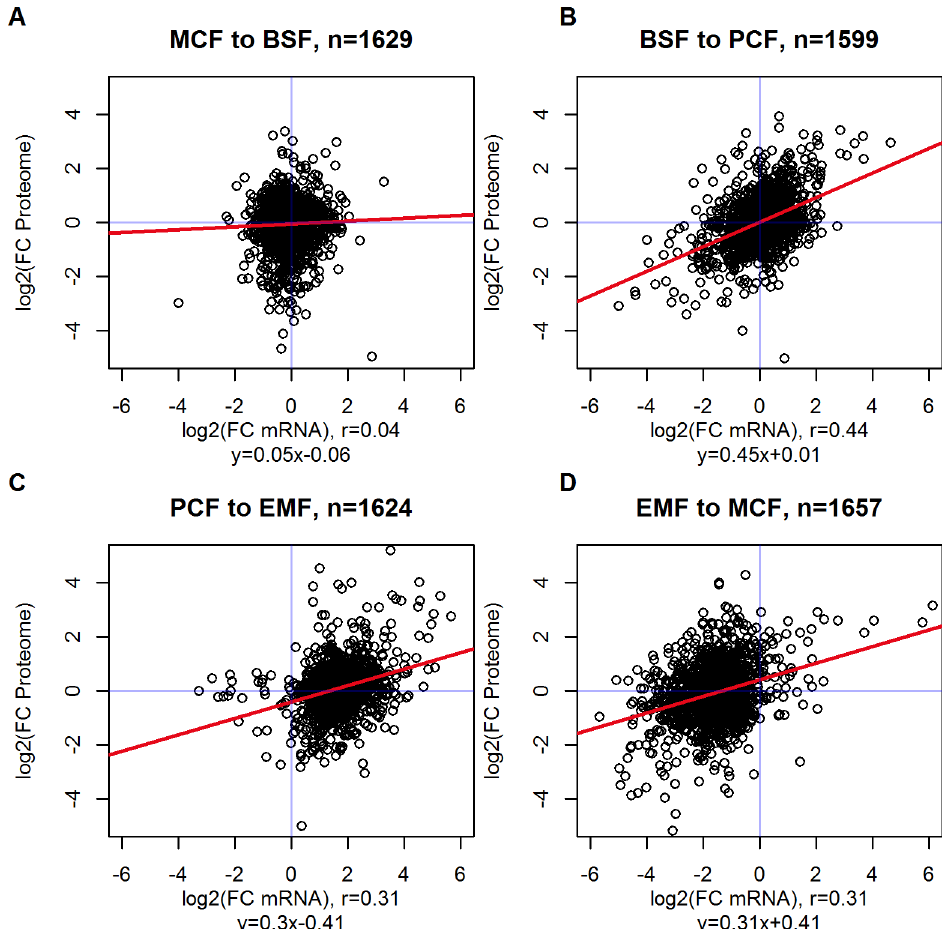
Fig 8. Correlation of mRNA and protein abundance. The correlation between transcript level and protein output is low, opening up a corridor for post-transcriptional gene expression regulation. The figure depicts comparison of relative fold changes (FC) of expression values between the stages. Translation efficiency is represented by the slope of the regression line. ( C , D ) From PCF to EMF and EMF to MCF the scatters are shifted on the x-axis, indicating an accumulation of transcripts in EMF, possibly due to an increased mRNA